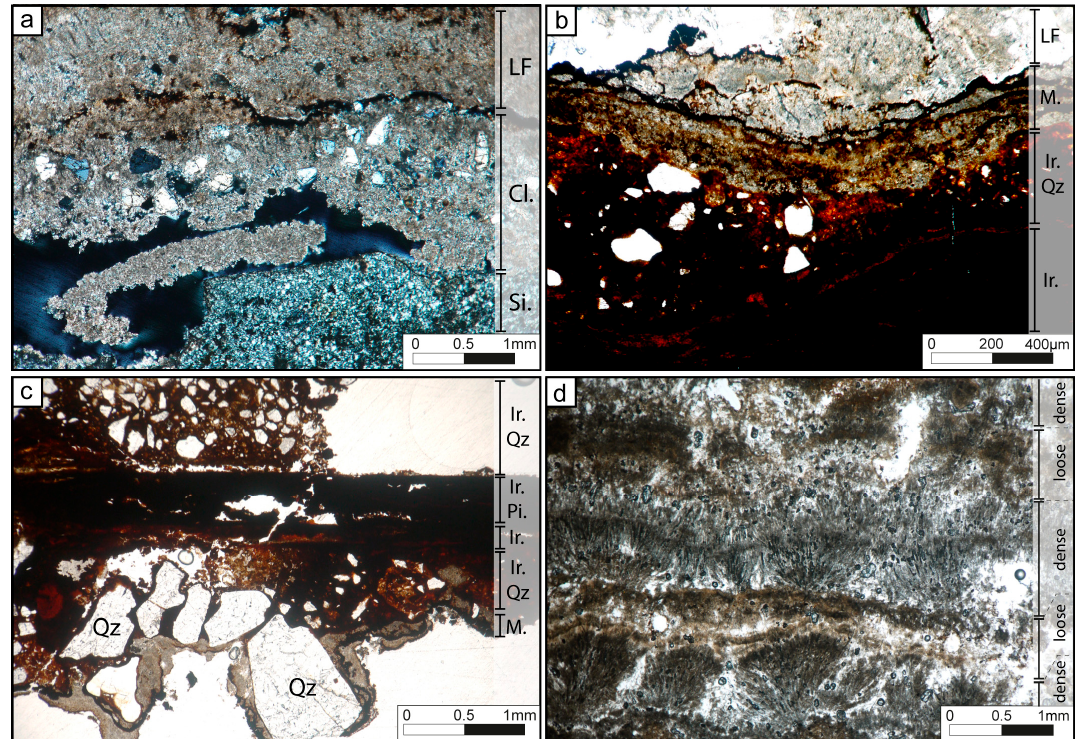
Figure 6. Microfabrics of tufa microbialites in thin section view. ( a ) Clastic-rich lamina (Cl.), composed of detrital grains embedded in microsparite and separated from loose filamentous laminae (LF) by a dark dissolution rim, overlying a siliceous substrate (Si.); ( b ) succession of iron-rich laminae without quartz (Ir.), and with quartz (Ir. Qz), micritic laminae (M.) and loose filamentous laminae (LF); ( c ) fragment of iron (Ir. Pi.) surrounded by iron-rich laminae (Ir.), iron-rich laminae with quartz grains (Ir.Qz) covered by two micritic laminae (M.); ( d ) alternation of dense and loose filamentous laminae. (5) Iron-rich laminae: 30 to 500 µ m-thick iron-rich laminae with µ m-thin goethite